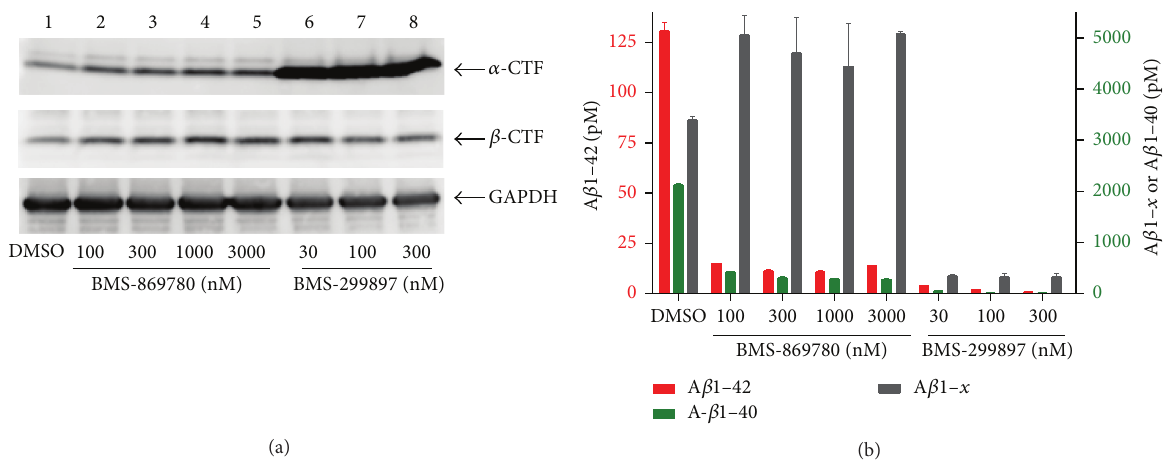
Figure 4: BMS-869780 had minimal effect on APP-CTF accumulation in vitro . H4-APPsw cell cultures were treated overnight with the indicated concentrations of BMS-869780, BMS-299897 or vehicle (0.1% DMSO). (a) Cells were harvested and analyzed by western blotting for APP-CTF 𝛼 , APP-CTF 𝛽 , and GAPDH. Lane 1; culture treated with vehicle 0.1% DMSO. Lanes 2–5; cultures treated with BMS-869780 at 100nM, 300 nM, 1000nM, or 3000 nM, respectively. Lanes 6–8; cultures treated with BMS-299897 at 30 nM, 100nM, or 300nM, respectively. (b) Levels of A 𝛽 1-42 (red; left 𝑌 -axis), A 𝛽 1-40 (green; right 𝑌 -axis), and A 𝛽 1- x (grey; right 𝑌 -axis) were